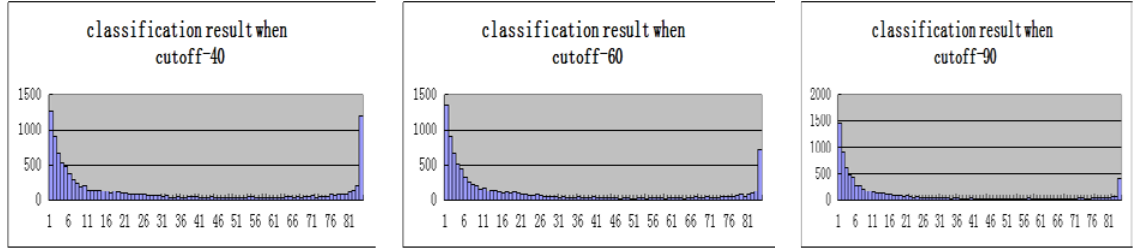
Figure 3: Relationship between the number of genes and the number of tissues that a given gene is classified using cutoff values 40, 60 and